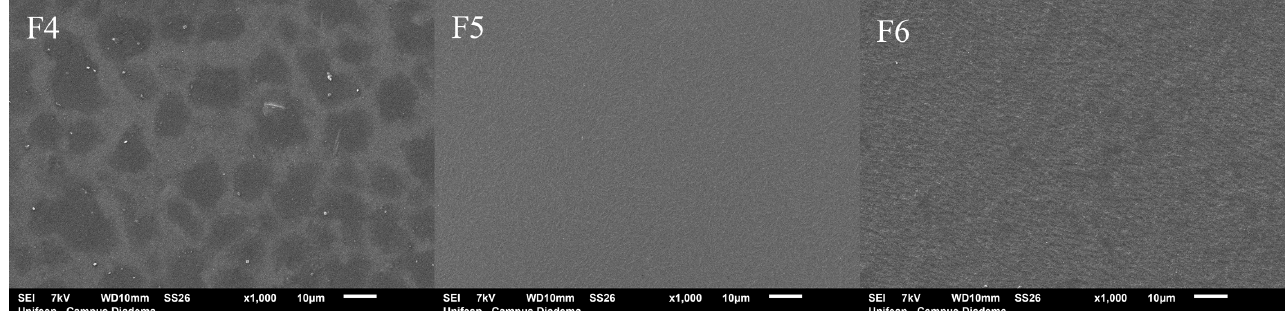
FIGURE 5 - Photomicrographs of orodispersible films obtained using scanning electron microscopy (SEM) Jeol with an increase of 1,000x.